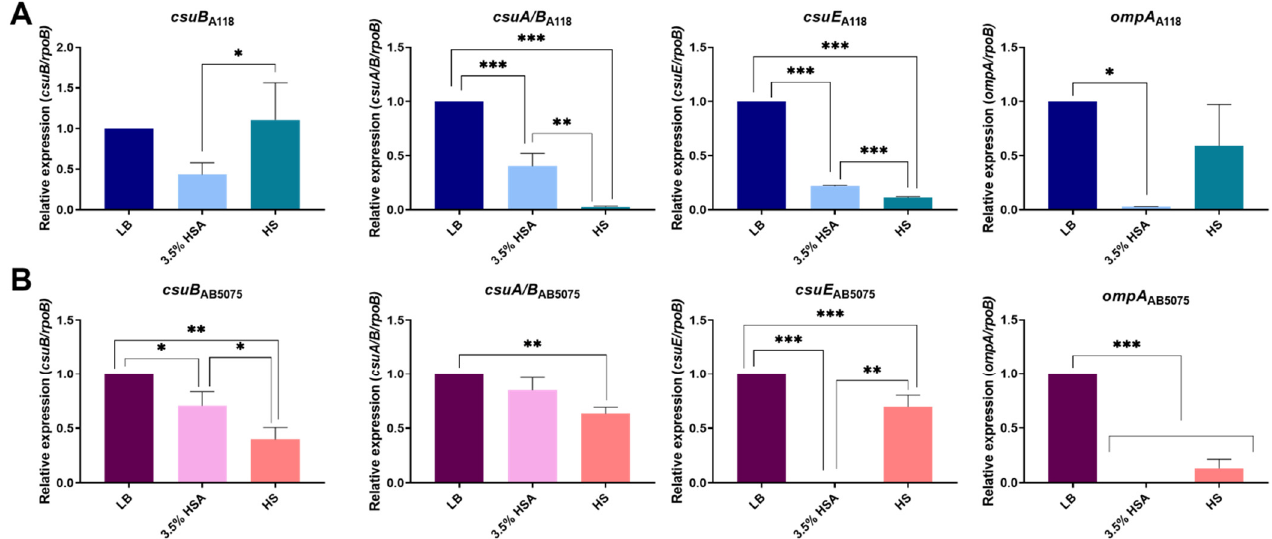
Figure 4. Effect of human serum albumin (HSA) and pooled normal human serum (HS) on the expression of biofilm formation genes in A. baumannii strains. qRT-PCR of A118 ( A ) and AB5075 ( B ) strains of the csuB, csuA/B, csuE, and ompA genes biofilm formation related in cells cultured in LB, LB supplemented with 3.5 % HSA, or in HS. Fold changes were calculated using double ∆∆ Ct analysis. At least three independent samples were used. LB was used as the reference condition. Statistical significance ( p < 0.05) was determined by ANOVA followed by Tukey’s multiple-comparison test, one asterisks: * p < 0.05; two asterisks: ** p < 0.01 and three asterisks: *** p < 0.001.